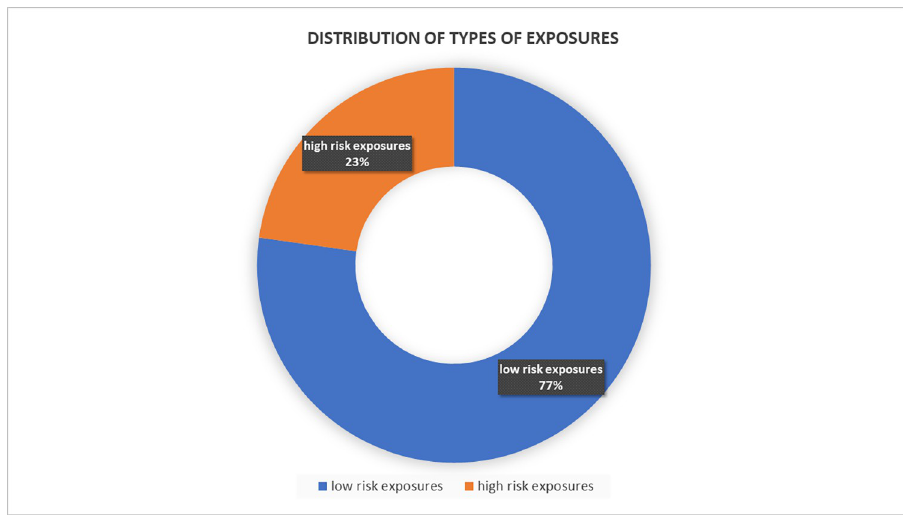
Fig 1. Distribution of types of